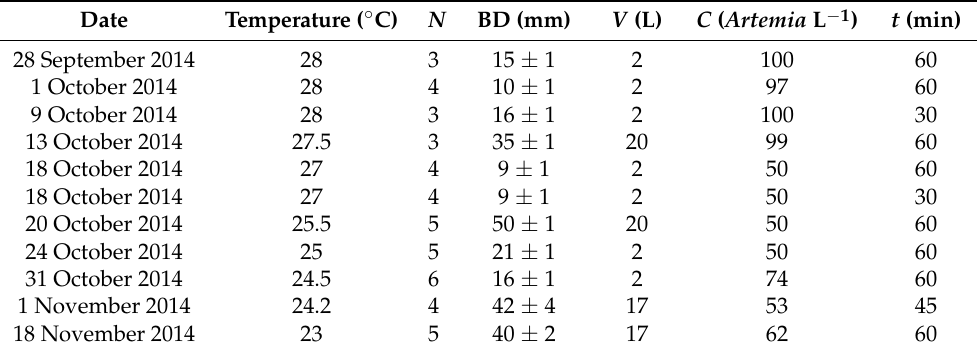
Table 2. Feeding trial setups: Newly hatched Artemia sp. nauplii were used as prey in all feeding trials. N = number of experimental tanks, V = volume of tank, C = concentration of prey, t = duration of each feeding trial. BD = bell diameter ± standard